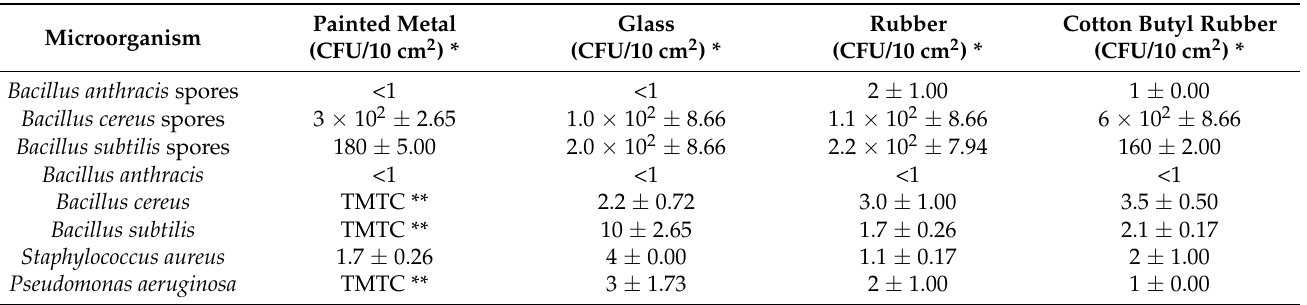
Table 3. Decontamination ‡ efficiency of the neat organic solution on various types of surfaces for different types of microorganisms.